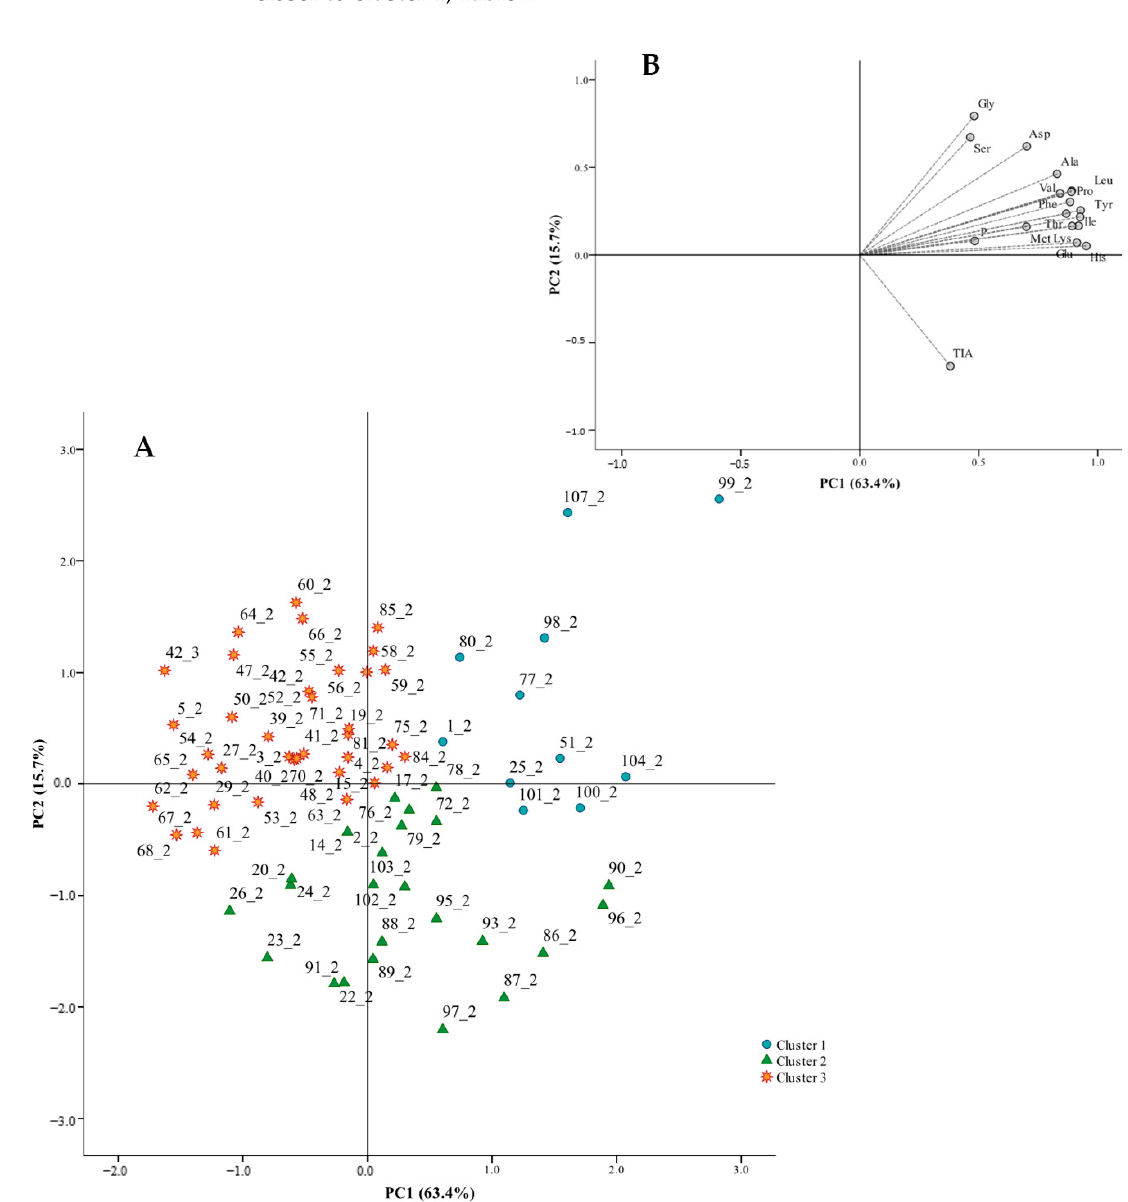
Figure 4. ( A ) Projection of Portuguese common bean accessions ( n = 72) collected from C ó rdoba field trial, considering the variables directly related to protein analysis ( B ) P − Protein; Gly − glycine; Ala − alanine; Ser − serine; Pro − proline; Val − valine; Thr − threonine; Ile − isoleucine; Leu − leucine; Asp − aspartic acid; Glu − glutamic acid; Met − methionine; His − histidine; Phe − phenylalanine; Tyr − tyrosine; Lys − lysine; Arg − arginine; TIA − trypsin inhibitor activity, in a bi-dimensional space (PC1 and PC2), responsible by 79.1% of the total variance. The clusters were highlighted by different colors and